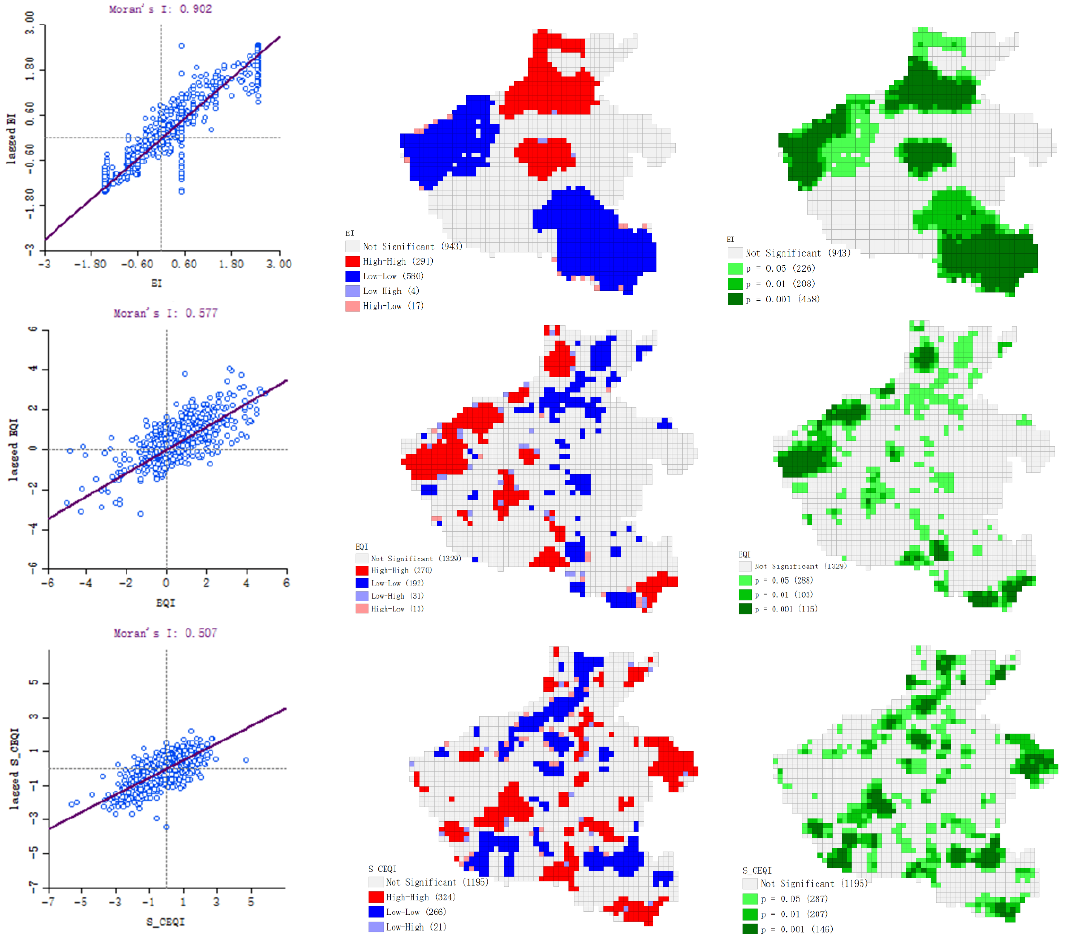
Figure 16. Spatial autocorrelation results showing Moran’s LISA cluster map, and LISA significance map of the change of ecological environment index from 1995 to 2019 .